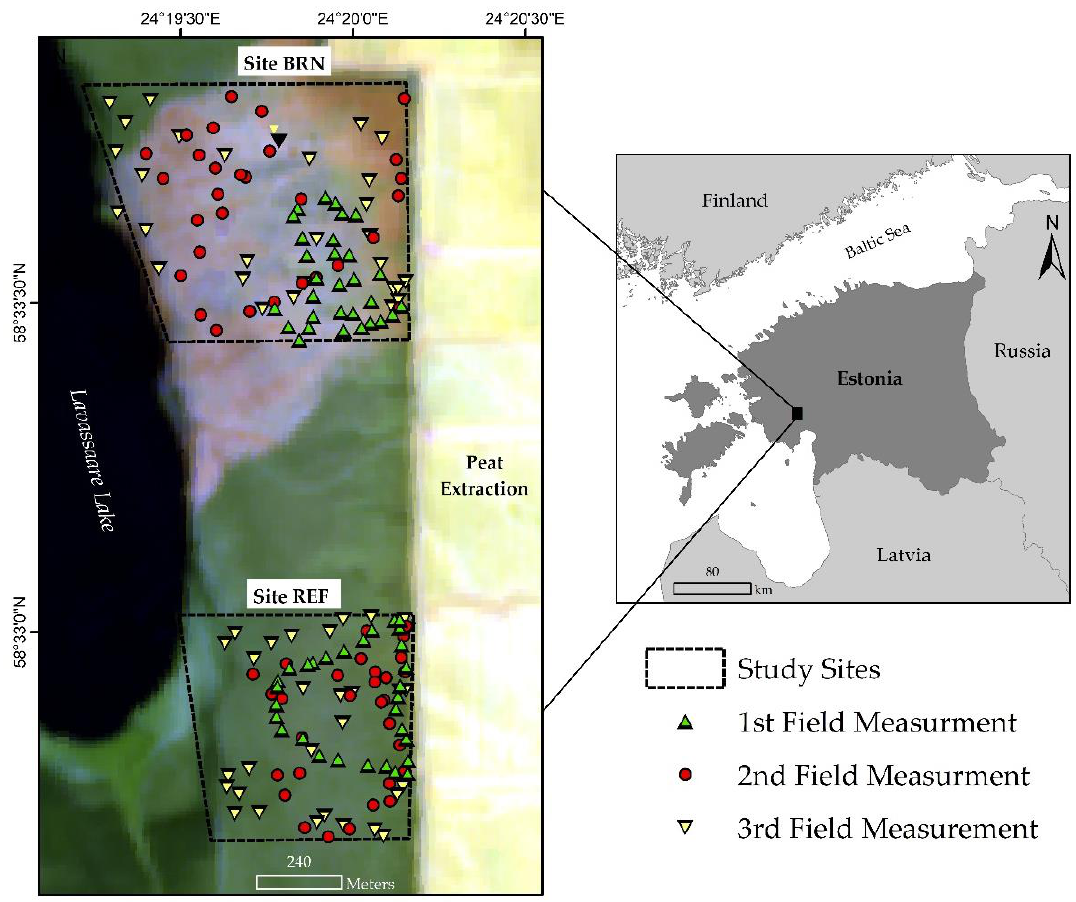
Figure 1. The location of the study sites and sampling plots within the Lavassaare Nature Reserve in West Estonia; background imagery is an average Sentinel-2 RGB-composite mosaic of the month of June 2020, highlighting the in situ conditions of vegetation after the fire event; site BRN = the area damaged by the fire, and REF = the undamaged area.